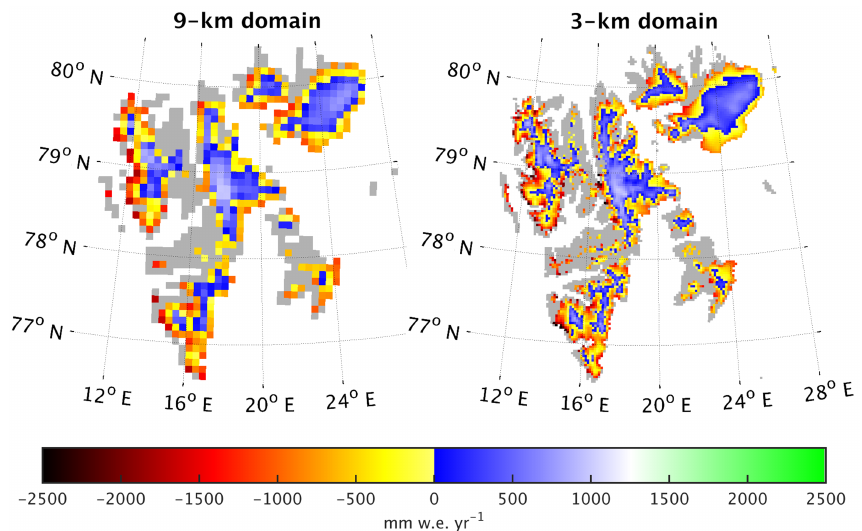
Figure 6. Mean annual CMB (mmw.e.yr − 1 ) from 2003 to 2013 simulated with 9km (left) and 3km (right) grid spacings.